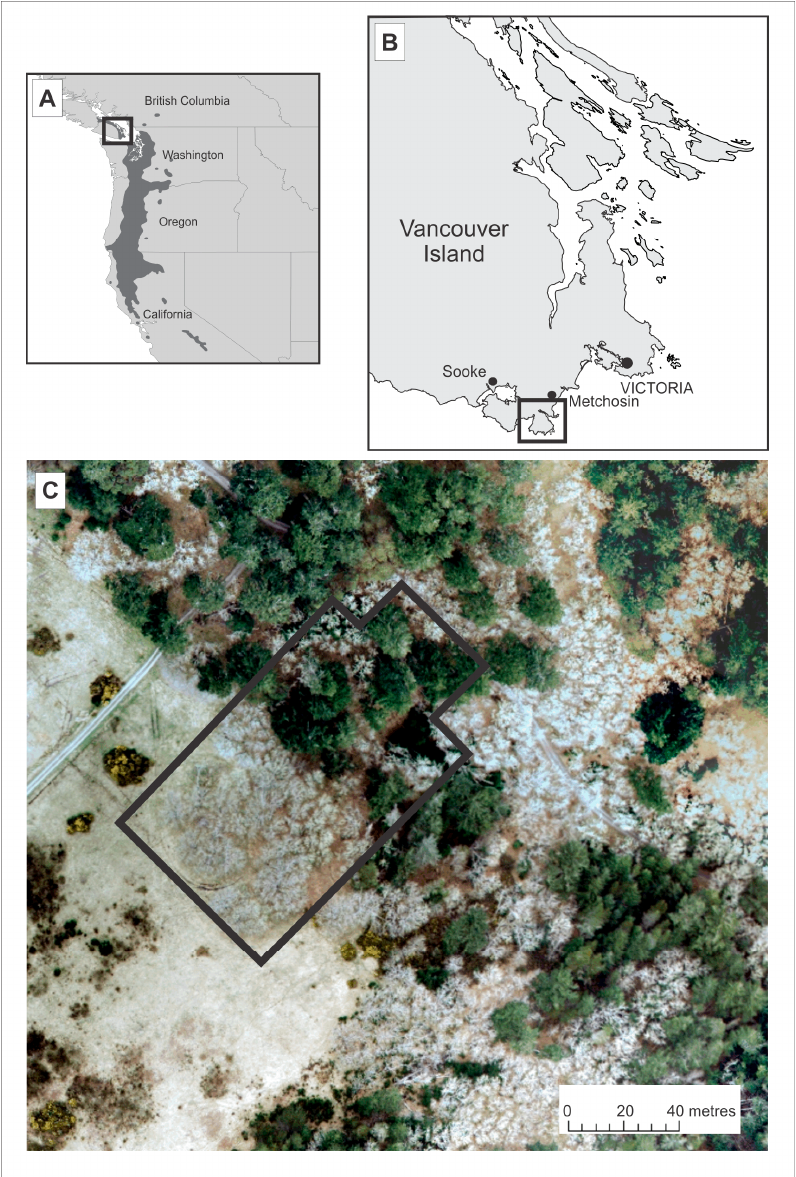
Figure 1. ( A ) The distribution of Oregon white oak in western North America. ( B ) Southern Vancouver Island. Rocky Point is located in the boxed area indicated. ( C ) A March, 2004, orthophoto of Rocky Point, and the approximate location of the study site. The oak has not leafed-out and appears much lighter in colour and less dense than the conifers toward the northeastern portion of the study area. North is oriented upwards. (After Gedalof et al. 2006; ref [16]).